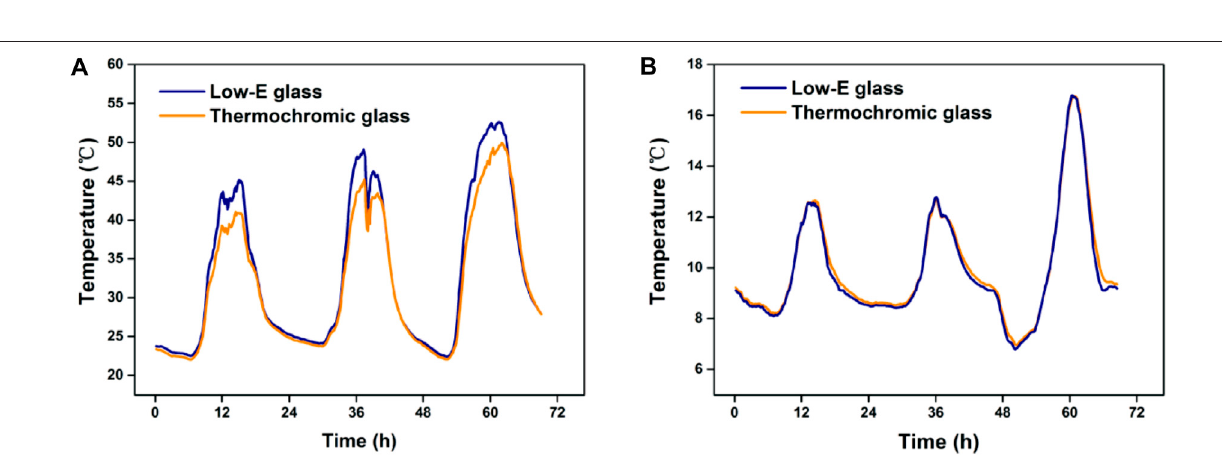
Frontiers in Materials |